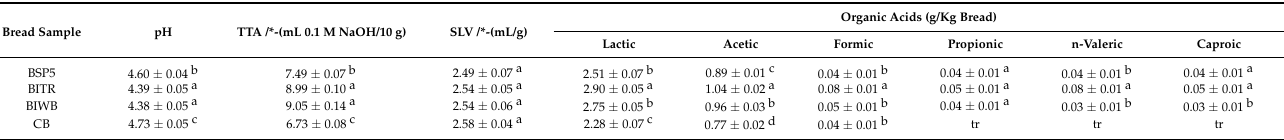
Table 1. Physicochemical characteristics of breads made with sourdoughs prepared with freeze-dried free and immobilized L. paracasei SP5 and with the control